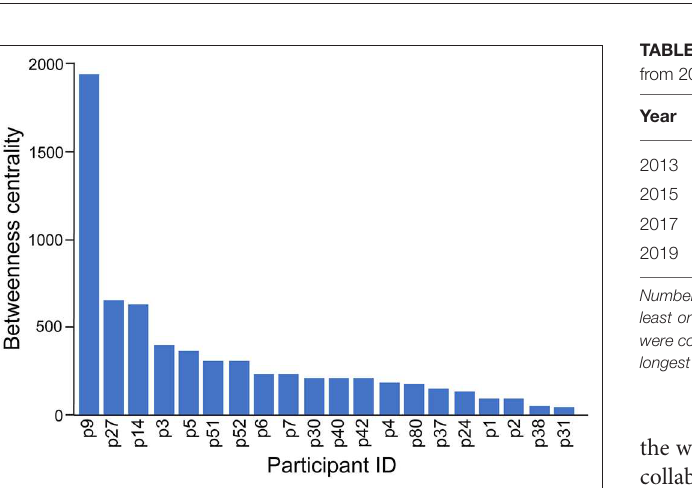
FIGURE 9 | The top 20 participants by betweenness centrality in the social network of workshop participation.